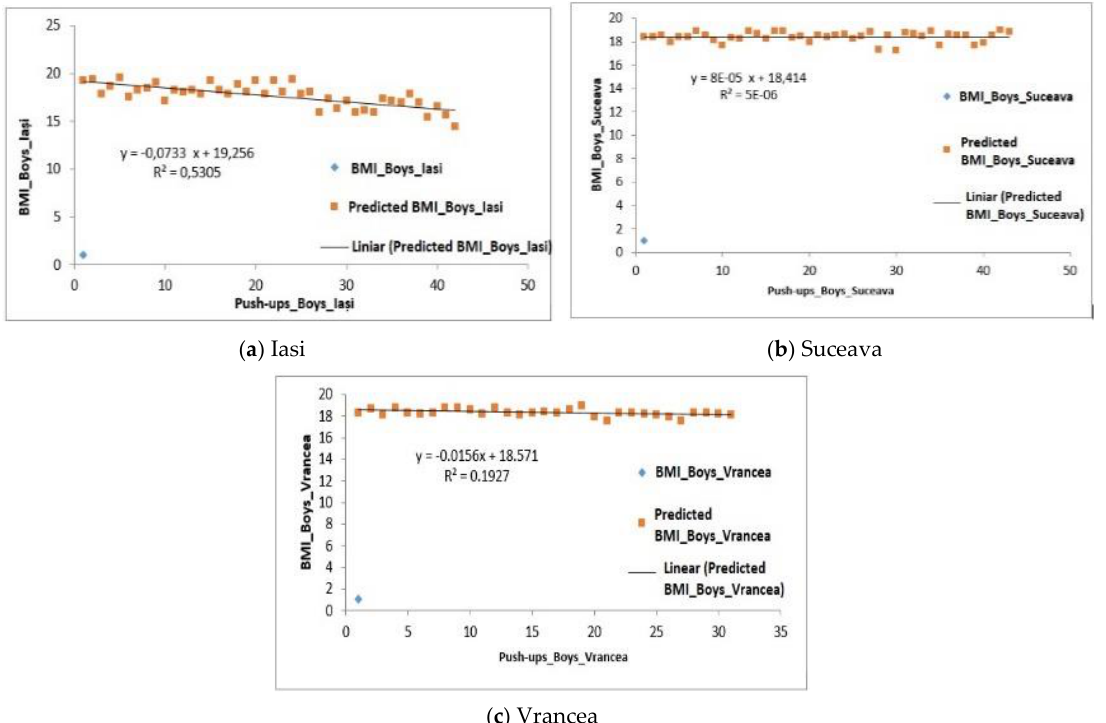
Figure 1. Relationship between the BMI and the number of push-ups performed by the male subjects in the three regions.